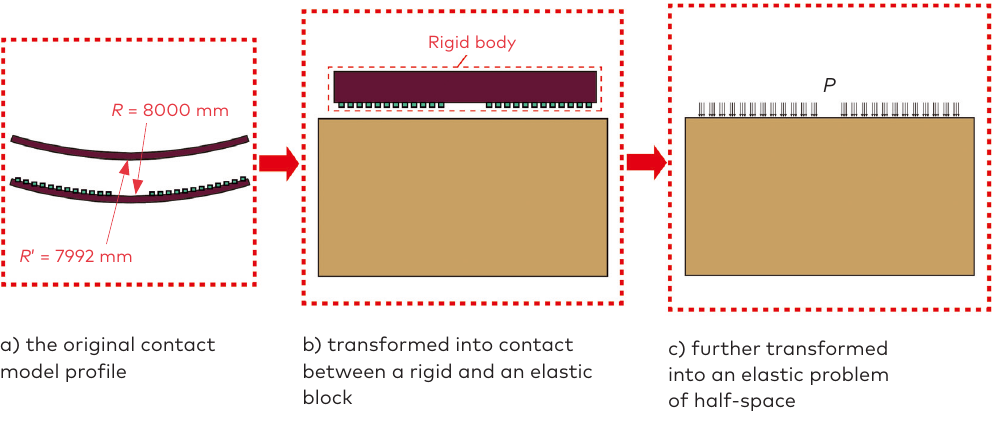
Figure 7. Simplification of the contact model: from multi-bodies contact problem to classic